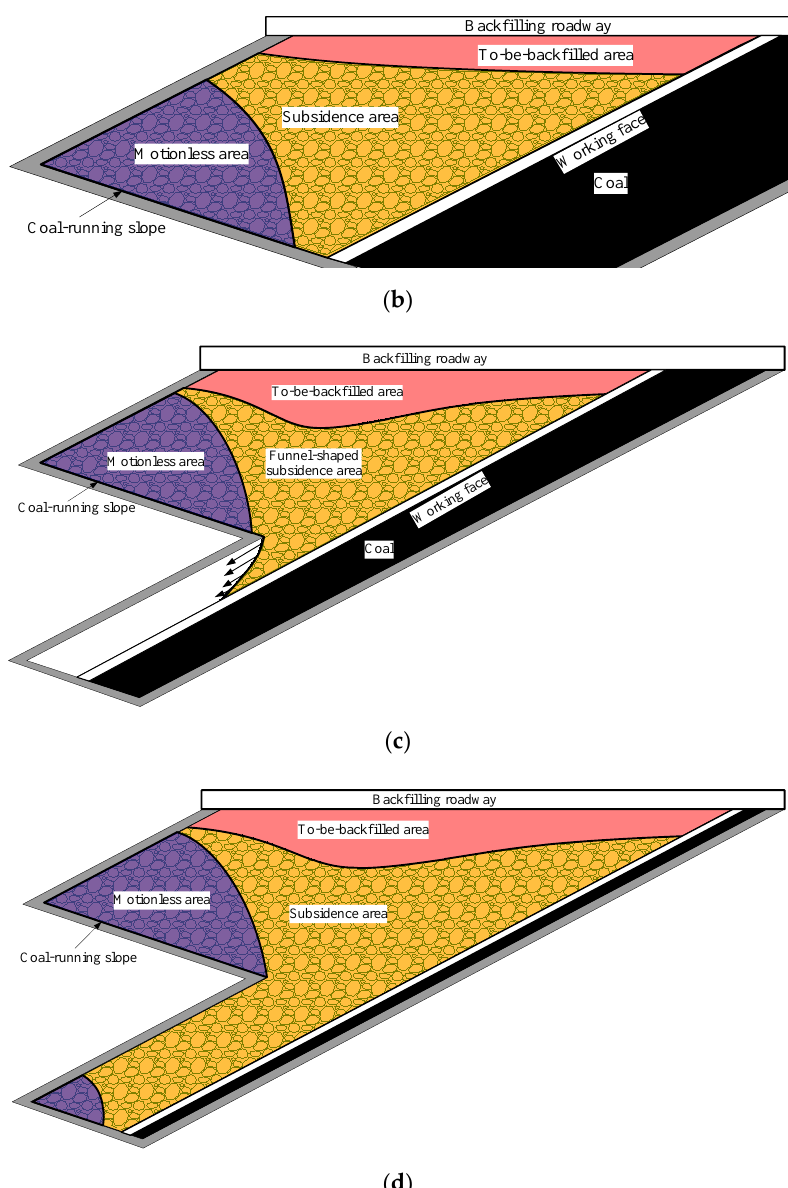
Figure 10. Division and evolution of the gangue moving area at the ( a ) landslide stage, ( b ) small-scale subsidence stage, ( c ) funnel-shaped subsidence stage and ( d ) large-scale subsidence stage.